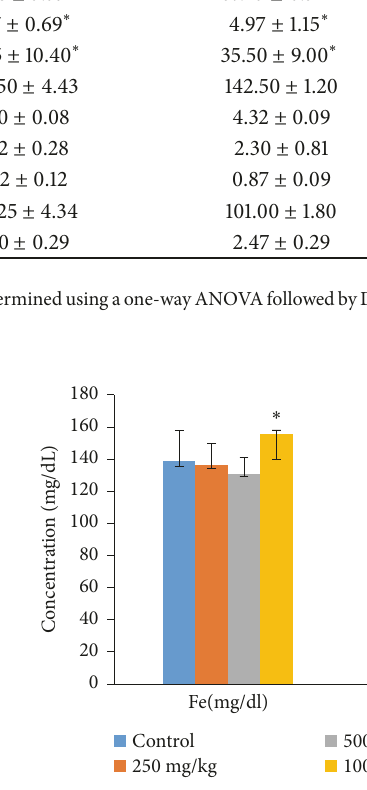
Figure 4: The effects of pomelo methanolic extract on serum iron profile. Results are expressed as mean ± SD (n=8). ∗ denotes level of significant difference when compared to control group (p < 0.05) as determined by using a one-way ANOVA followed by Dunnett’s multiple comparison